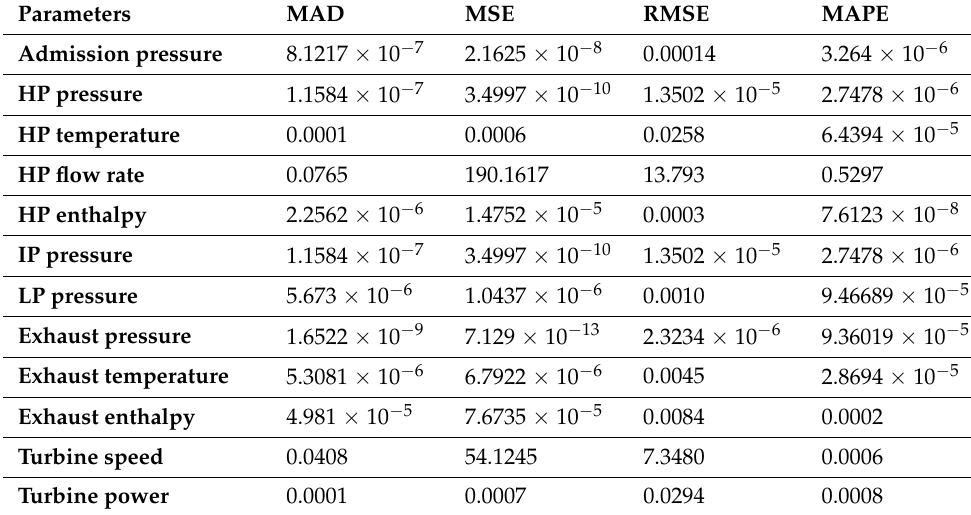
Table 8. Simulation results evaluation for steam